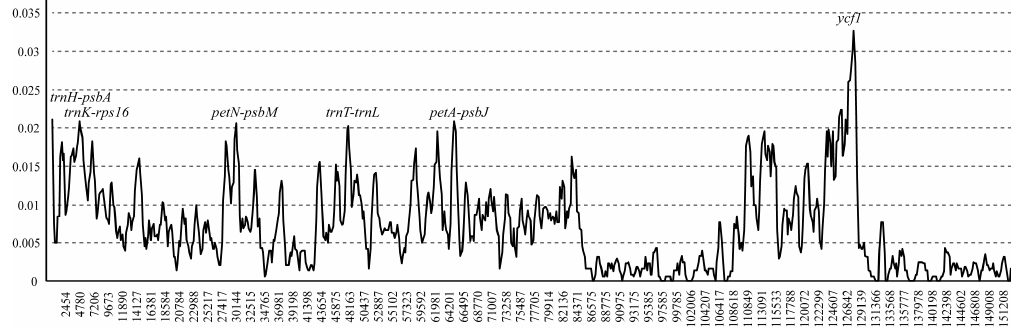
Figure 4. Sliding window analysis of the whole chloroplast genomes of three Scutellaria species. Window length: 800 bp; step size: 200 bp. X-axis: position of the midpoint of a window. Y-axis: nucleotide diversity of each window.